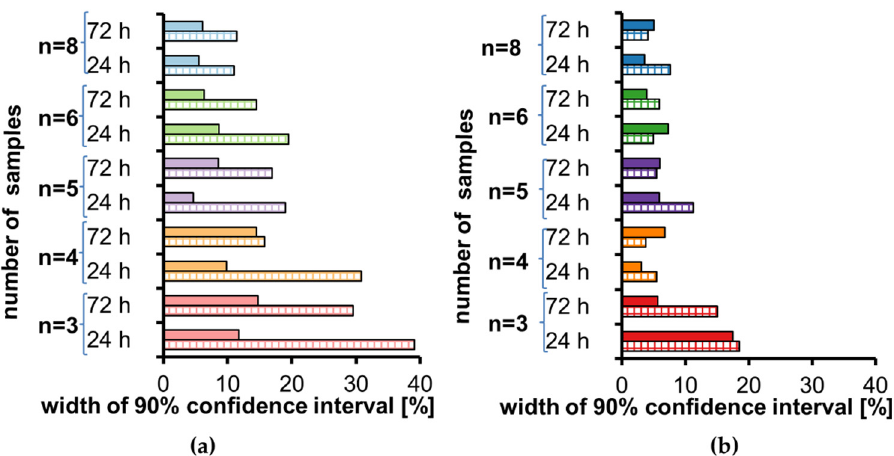
Visual assessment of low concentration data (Figure 2a) indicates that three and four repetitions are not appropriate due to the width of some confidence intervals over 30%. For five and six repetitions, width is below 20%, while for eight repetitions, width is below 12%. Visual assessment of high concentration data (Figure 2b) is a bit different. For three repetitions the confidence intervals width in 3/4 cases is over 15%, while for all other repetitions it is below 8%, with one exception of 11% ( n = 5).